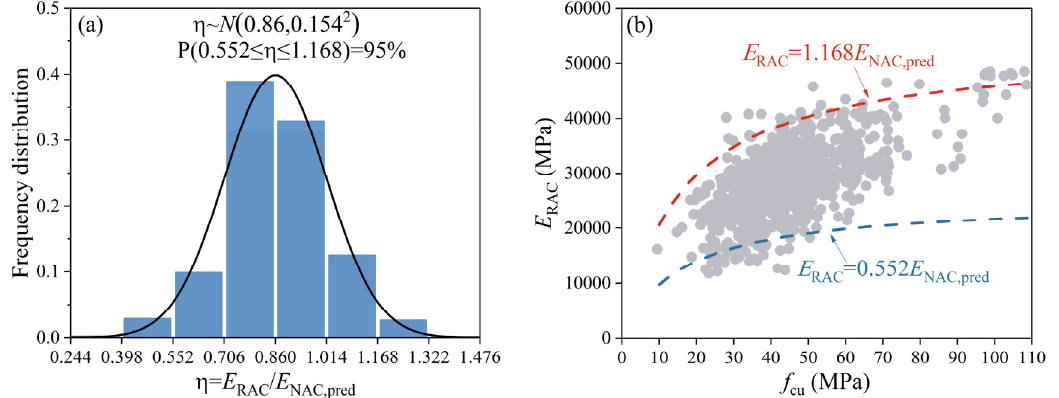
Figure 4. Distribution of η and E RAC [21,22,28–167,169–174]. ( a ) η ~ N (0.86,0.154 2 ); ( b ) 1.168 E NAC,pred ≥ E RAC ≥ 0.552 E NAC,pred .